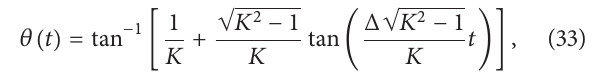
Figure 6: Time waveforms and frequency spectra obtained by SPICE simulations of the circuit in Figure 1 for 𝐿 = 4 nH, 𝐶 = 2 pF, 𝑅 = 400 Ω , and 𝐼 0 = 1 mA. Injection amplitude and frequency determine 𝑘𝑉 (0) = 0.1 𝑉 and 𝑖 (0) = 1 mA. (b) Waveform obtained with initial conditions: V V 𝐶 𝐿 waveform in (a). (d) Spectrum of the waveform in